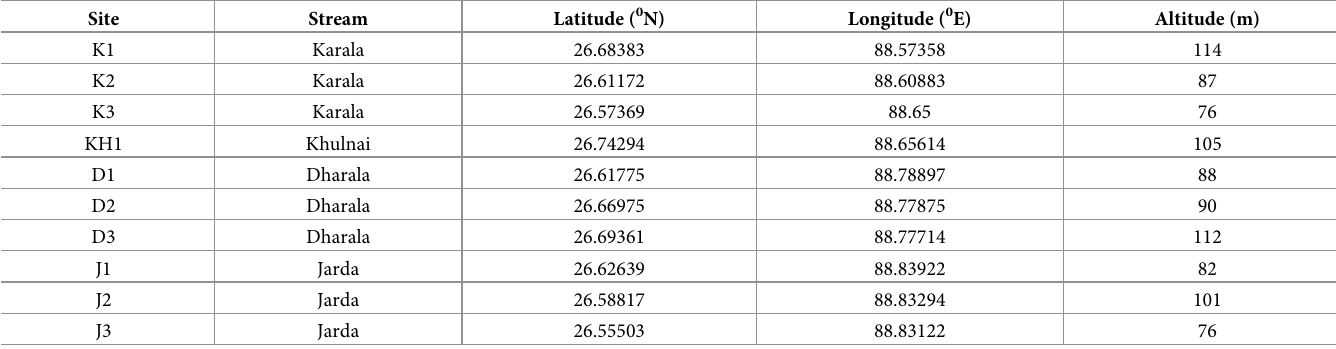
Table 2. Site names, location and description for West